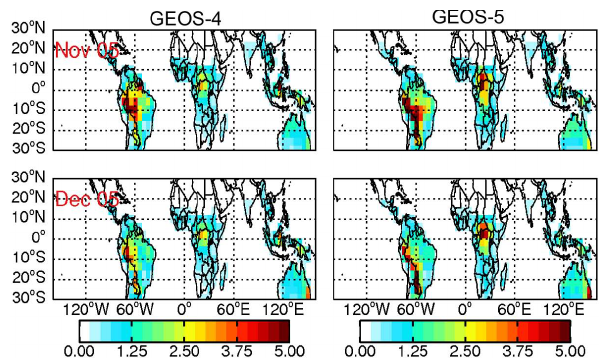
Fig. 13. Isoprene emissions (10 12 atomsCcm − 2 s − 1 ) in November (top) and December (bottom) 2005 in the model driven by GEOS-4 (left) and GEOS-5 (right).